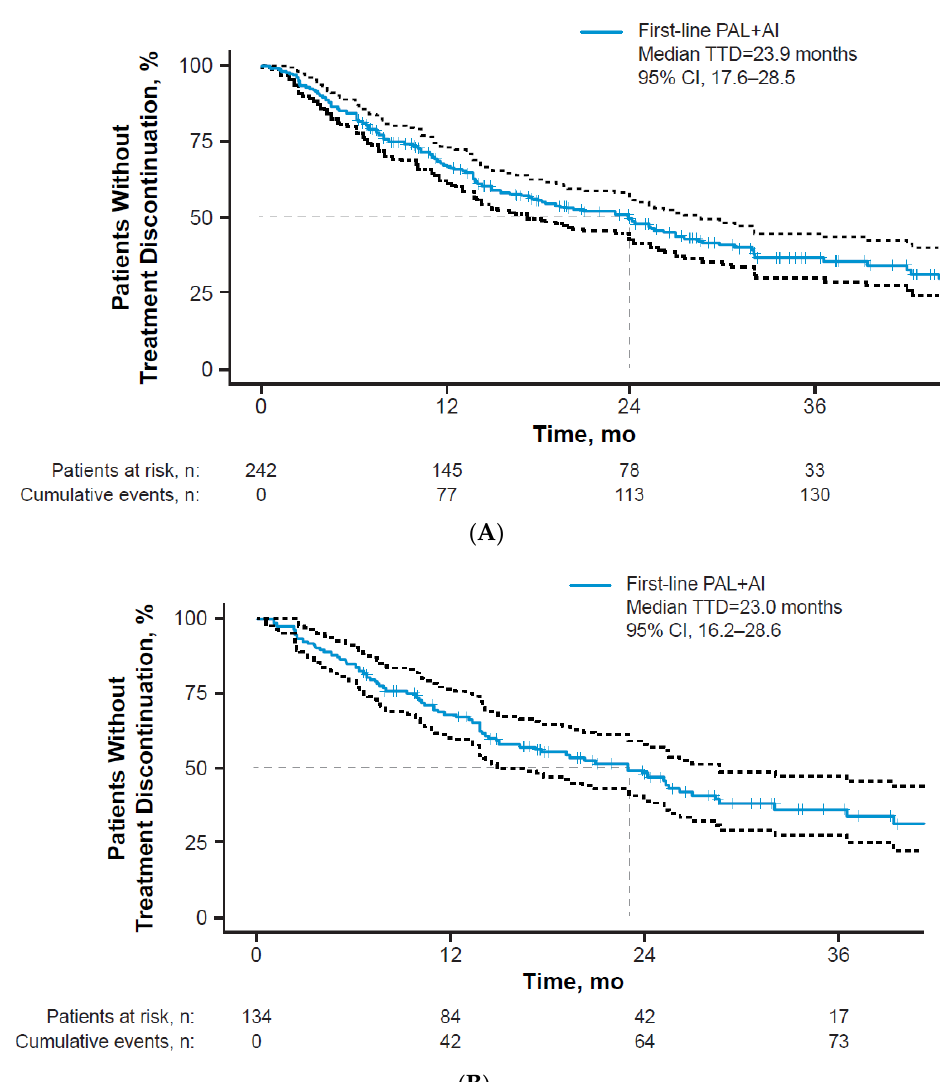
Figure 2. Kaplan-Meier curve of time to treatment discontinuation ( A ) among all patients and ( B ) among patients with stage IV disease at breast cancer diagnosis. AI = aromatase inhibitor; PAL = palbociclib; TTD = time to treatment discontinuation. Table 3. Palbociclib dosing information ( n = 242).